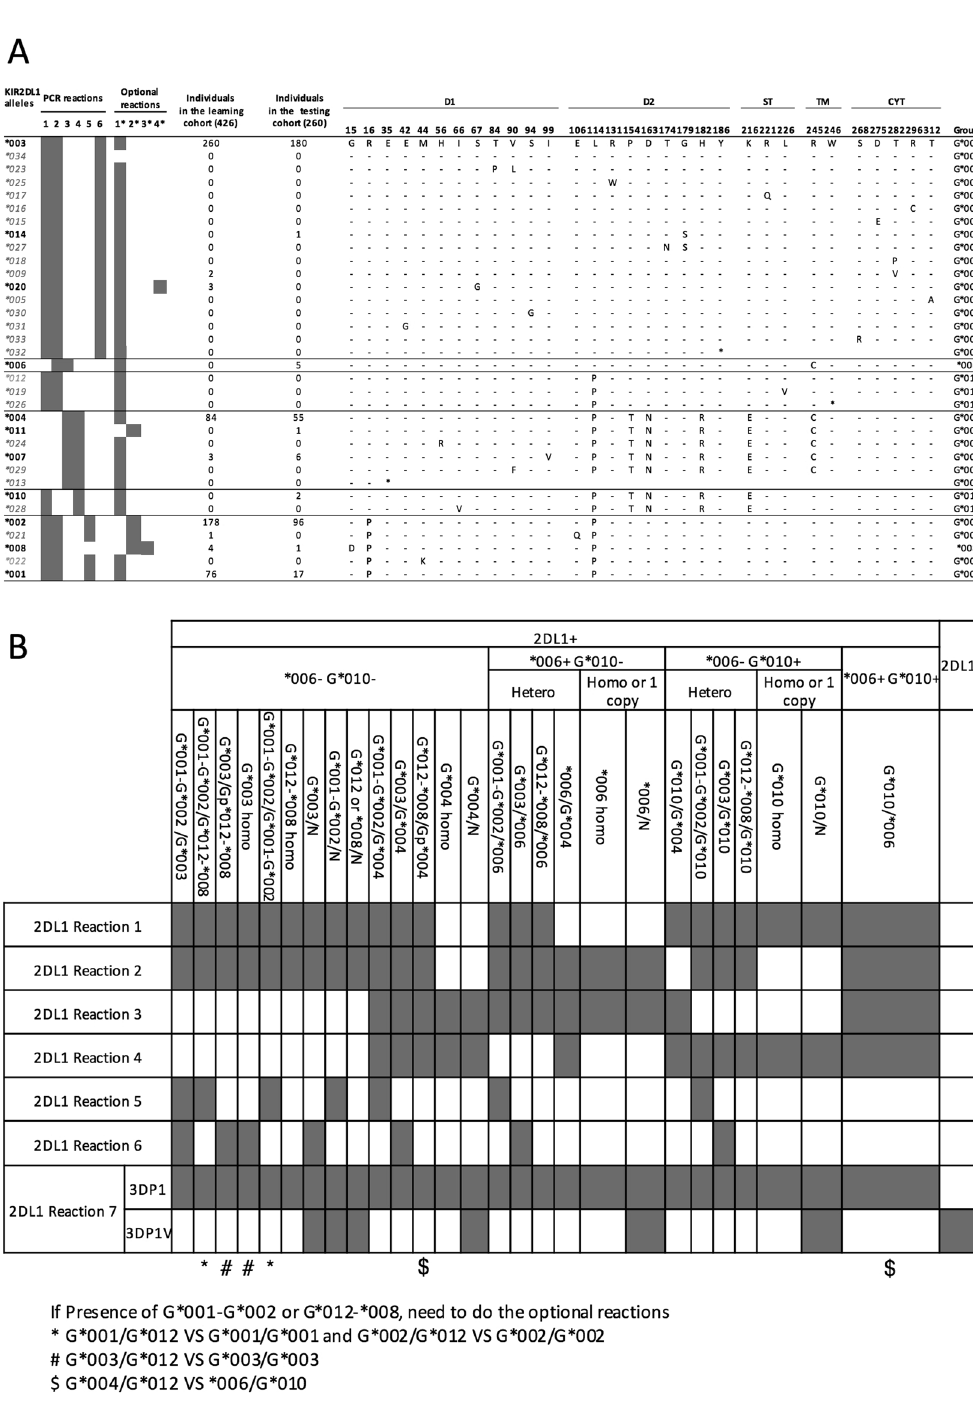
Figure 1. KIR2DL1 allele typing method. ( A ) Alignment of the amino acid sequences of the 34 known KIR2DL1 allelic variants. A dash indicates identity with the consensus KIR2DL1 * 003 , and an ( * ) indicates a stop codon. Structural domains are indicated: Ig-like domains (D1 and D2), stem domain (ST), transmembrane domain (TM), and cytoplasmic domain (CYT). Six PCR reactions separate the six subgroups identified by phylogenetic analysis. Four additional PCR reactions separate alleles within subgroups. Frequencies of the alleles present in the learning cohort of 426 individuals and in the testing cohort of 260 individuals are indicated. The group identification number for each allele is indicated. Alleles identified by PCR are in bold black font, and alleles that were not tested are in gray italics. ( B ) KIR2DL1 PCR interpretation guide. PCR profiles marked by * , #, or $ are similar and require a higher resolution of genotyping using supplemental